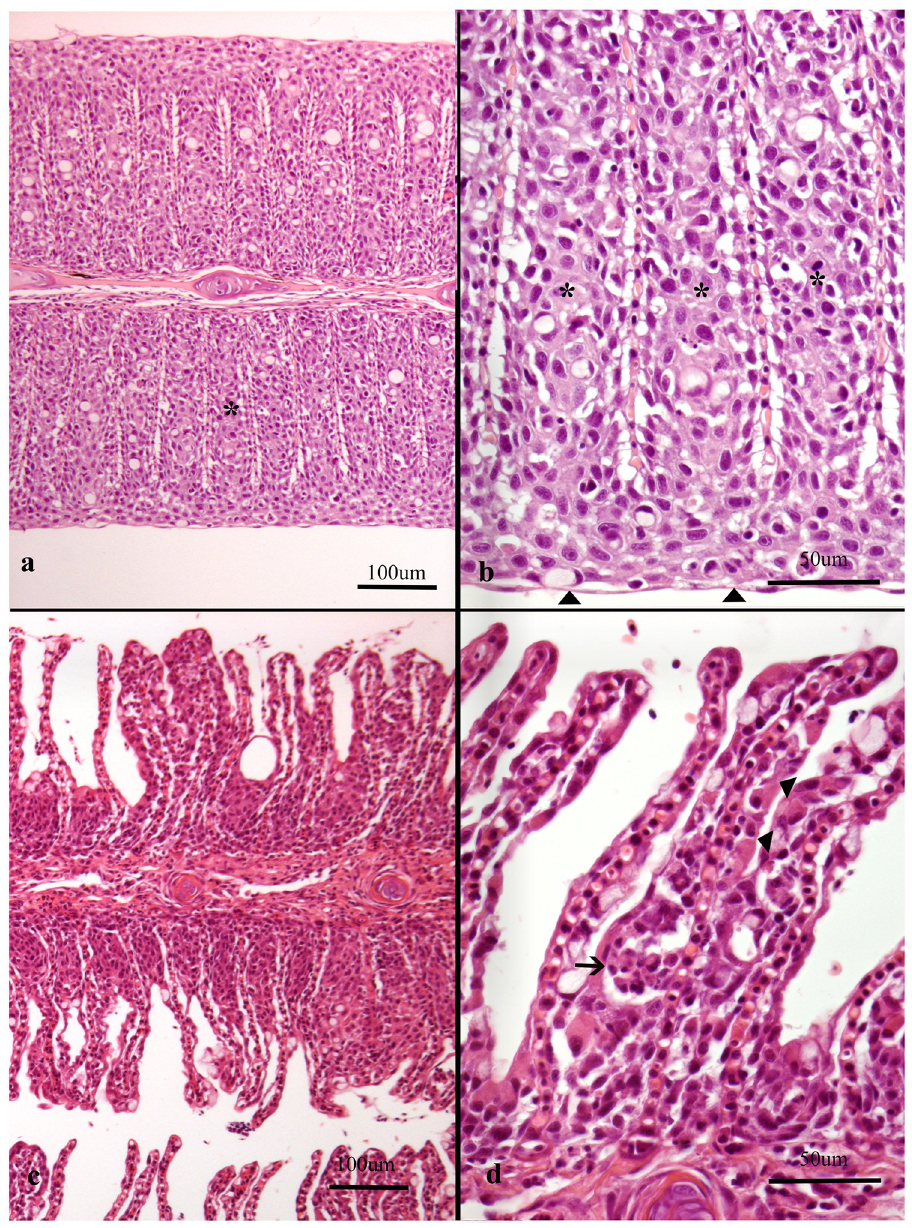
Fig 3. Histological sections of gills from Atlantic salmon. Note that plane of section is consistently on the efferent side of the gills in all images as judged by the small amount of filament cartilage. (a-b) Gills from farm 3 were dominated by Paramoeba perurans in addition to Ca . Branchiomonas cysticola and Desmozoon lepeoptherii . (a) Note extensive epithelial cell hyperplasia (asterisk) (scored 7) causing total obstruction of respiratory surface (b) extensive epithelial cell hyperplasia (asterisk) and metaplasia (arrowheads), scored 5. Note apparently unaffected lamellar vessels. (c-d) Gills from farm 22 were dominated by Ca . Branchiomonas cysticola. (c) note thickened lamellae caused by epithelial cell hyperplasia, scored 5 and some mucus cell hyperplasia, scored 3 and subepithelial leukocytes, scored 5. (d) subepithelial inflammatory cells and dead cells (arrow) and chloride cell hyperplasia (arrowheads), scored 3.